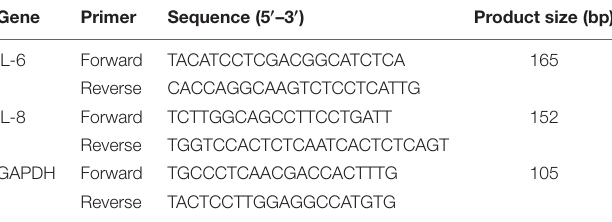
FIGURE 1 | Effects of FSGTC on the destruction of cartilage in OA rats, assayed by S-O staining. Rats were treated without (B,F) or with 200 mg/kg (C,G) and 400 mg/kg (D,H) FSGTC before papain injection; sterile saline solution injection was used for the sham group (A,E) (original magnification × 100 or × 200).